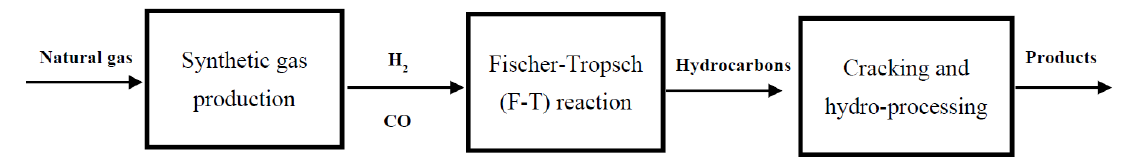
Figure 1. Flow diagram of the gas to liquid (GTL) process with main units and generated wastewater streams [114].